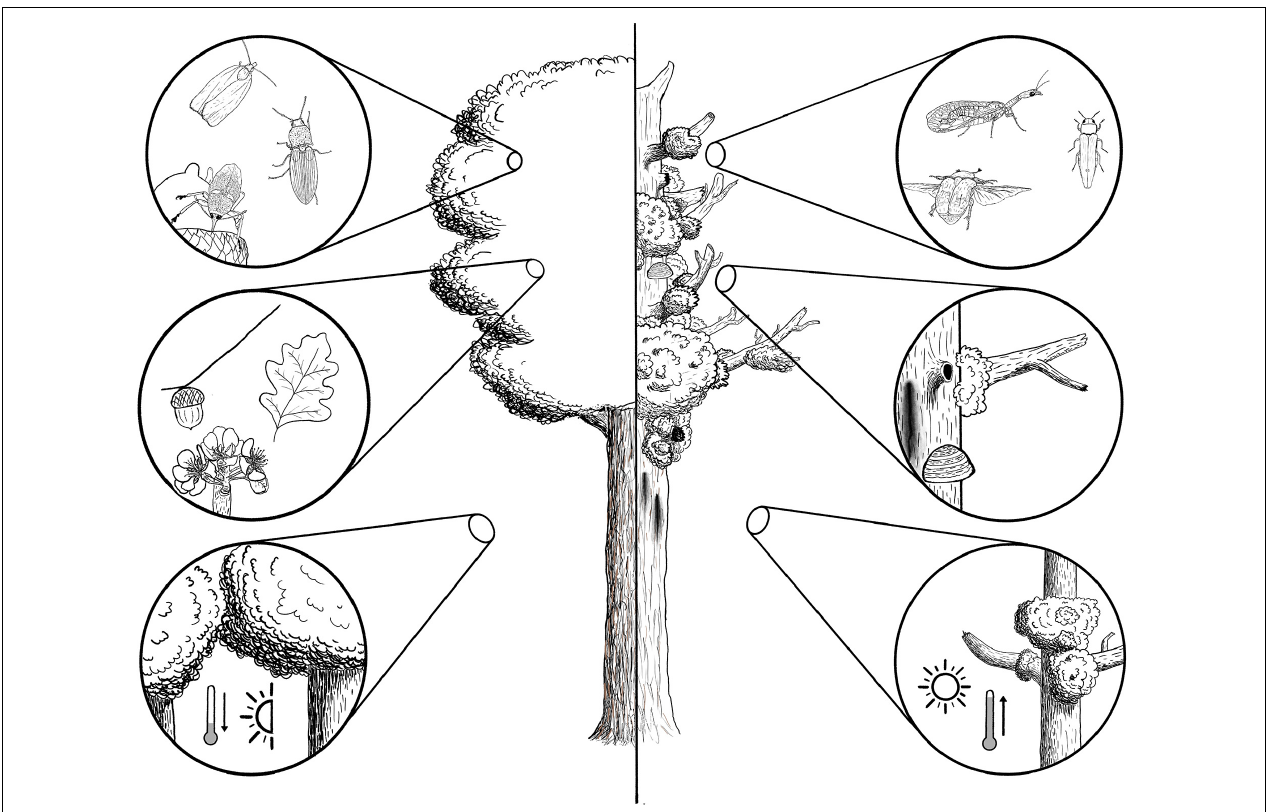
FIGURE 2 | Overview of decline-induced changes in arthropod communities (upper insets), resources and habitats (medium insets), and microclimates (lower insets) in forest canopies. Declining tree crowns (left part) should affect leaf-dwelling species but promote saproxylic species by reducing foliage, flower, and seed amounts but accumulating tree-related microhabitats like perched dead branches, fermented sap exudates, cavities, and fruiting bodies of pathogenic fungi. Reduced canopy cover will also reduce the thermal buffer on lower forest strata but increase the luminosity. Credits: Jérémy